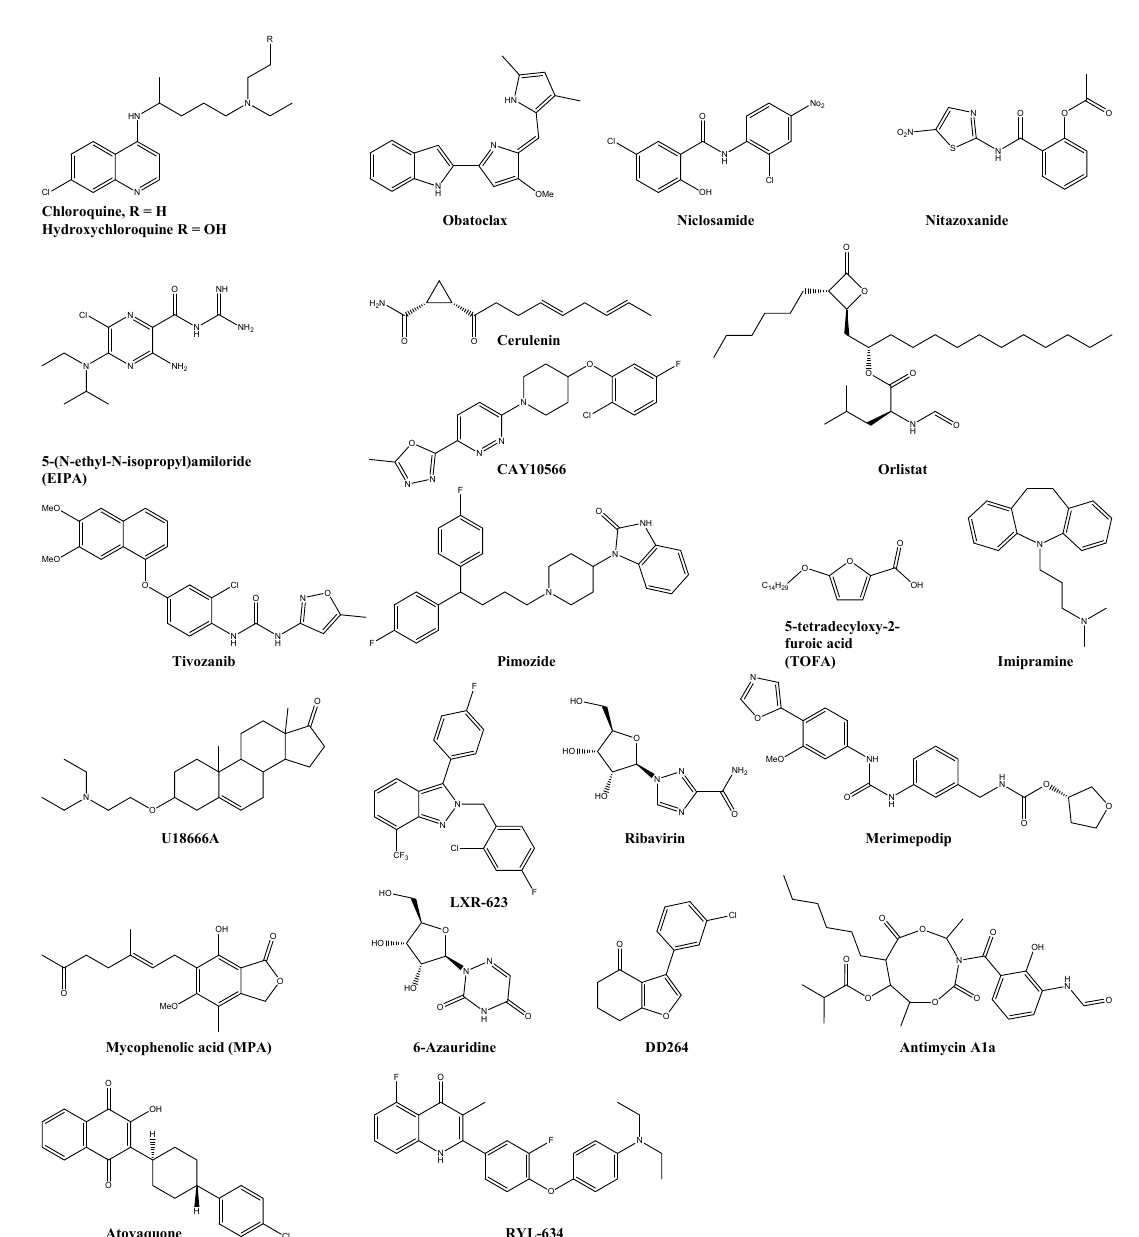
Figure 3. Chemical structure of selected host-targeting compounds. Inhibitor of the viral entry and membrane fusion: chloroquine, hydroxychloroquine, obatoclax, niclosamide, nitazoxanide, and 5-(N-ethyl-N-isopropyl)amiloride. Inhibitor of the lipid pathway: orlistat, cerulenin, CAY10566, tivozanib, pimozide, 5-tetradecyloxy-2-furoic acid, imipramine, U18999A, and LXR-623. Inhibitor of the pyrimidine and purine synthesis: ribavirin, merimepodip, mycophenolic acid, 6-azauridine, DD264, antimycin A1a, RYL-634, and atovaquone.